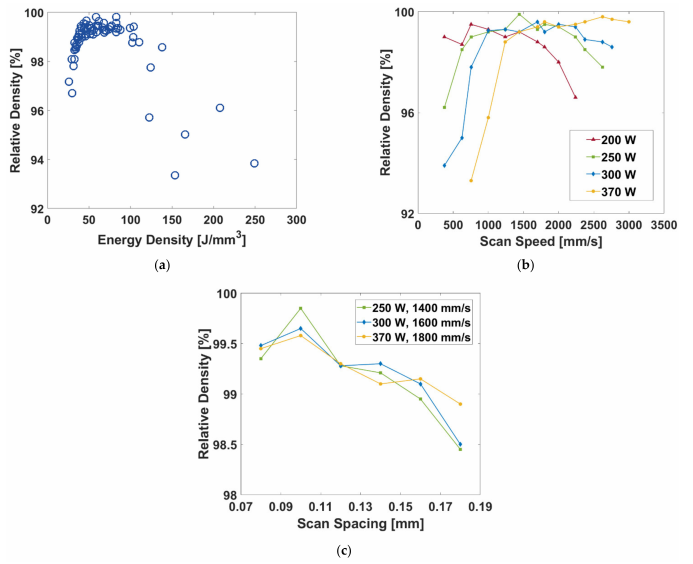
Figure 6. Influence of energy density ( a ), scan speed ( b ), and scan spacing ( c ) on the relative density of AlSi7Mg0.3 printed by L-PBF. Redrawn from ref.